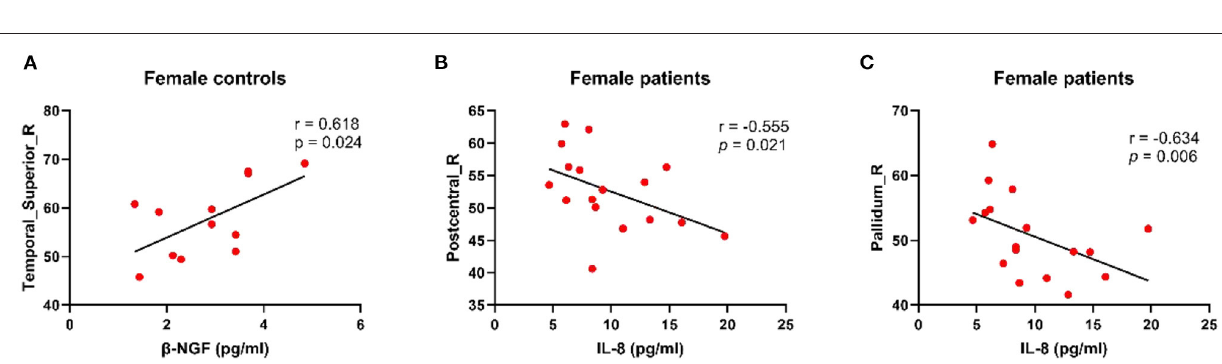
FIGURE 3 | Results of brain region changes in mTBI male patients compared with female patients. The CBF of male patients in left precuneus (A) is lower than female patients, while the right pallidum (B) showed increased perfusion levels. mTBI, mild traumatic brain injury; CBF, cerebral blood flow.